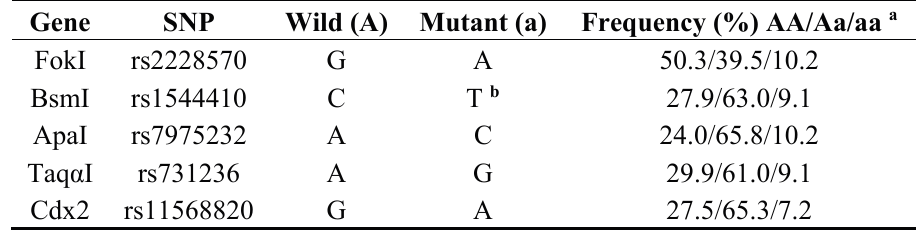
Table 2. Vitamin D receptor polymorphisms distribution in 974 children aged <10 years (Acrelândia, Brazil,